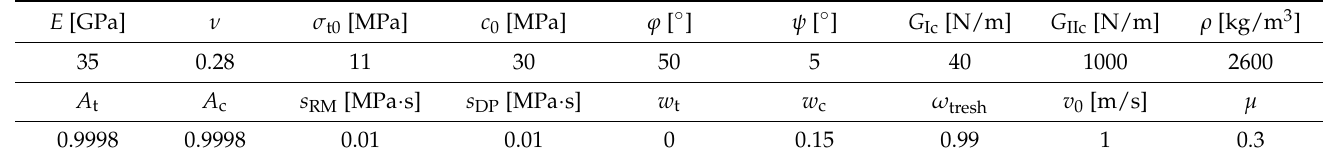
Table 1. Material properties (from [4]) and model